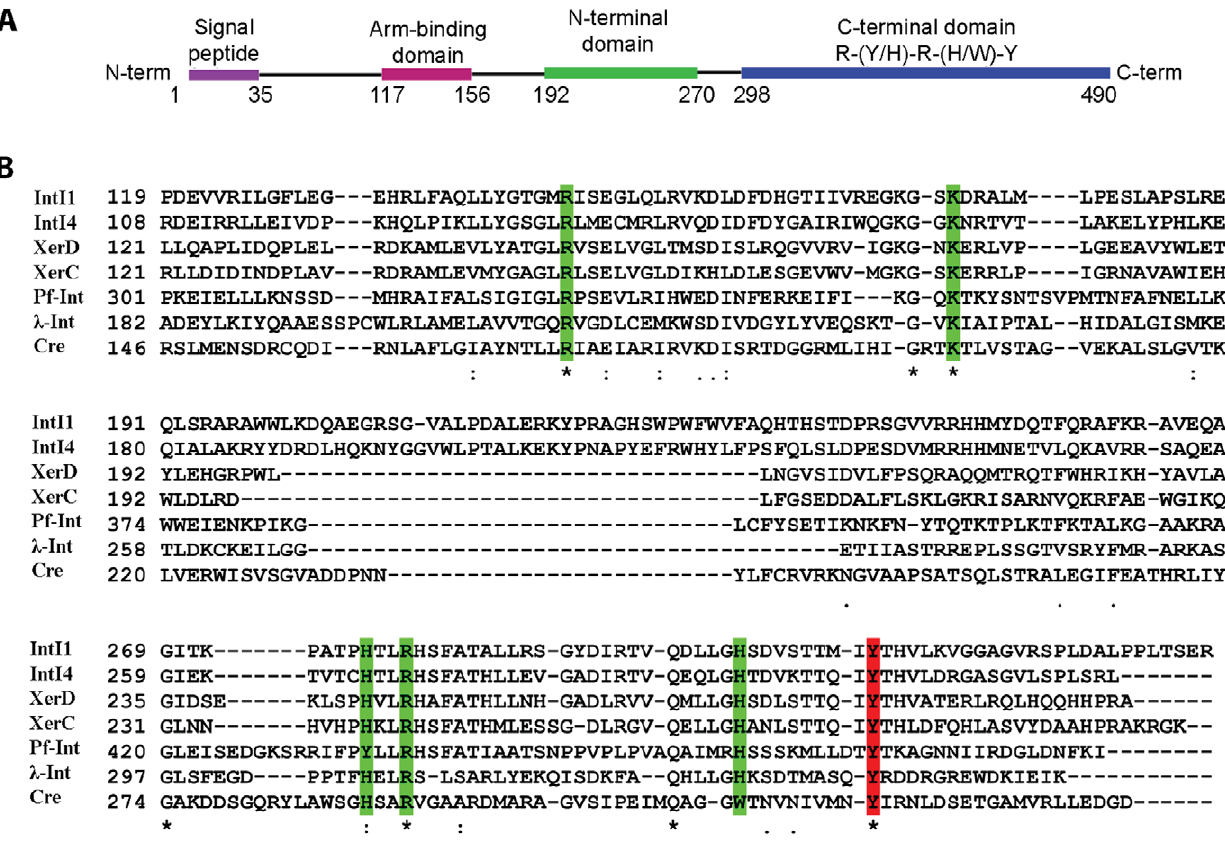
Figure 1. Pf-Int is a tyrosine recombinase. A ) Schematic representation of domain organization of Pf-Int. The integrase is 490 amino acids long and is predicted to have two DNA-binding domains, the Arm binding domain (117–156 aa residues) and the core-binding domain (192–490 aa residues). The core binding domain is made of the two domains classically found in Y-SSR: the N-terminal domain (green) and the C-terminal catalytic domain (blue) that contains the catalytic residues R-K-(Y/H)-R-H/W-Y. B ) Sequence alignment using Pf-Int and members of the tyrosine recombinase family ( l -integrase, Cre, XerD, XerC, IntI1, IntI4). Conserved catalytic residues (R-K-H-R-H/W) are depicted in green. The catalytic tyrosine is depicted in